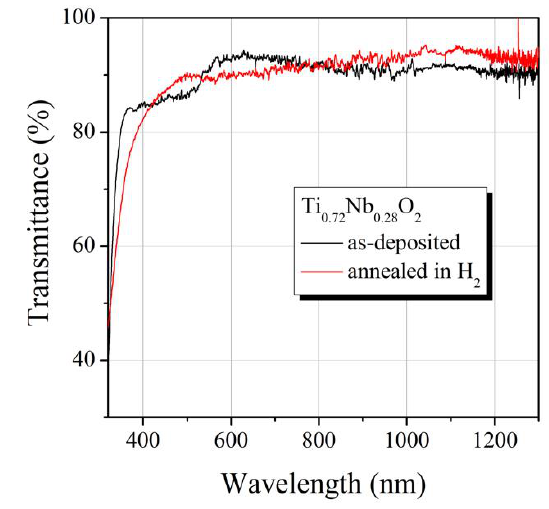
Figure 3. Transmittance of the annealed and as-deposited Ti 0.72 Nb 0.28 O 2 film on a glass substrate.